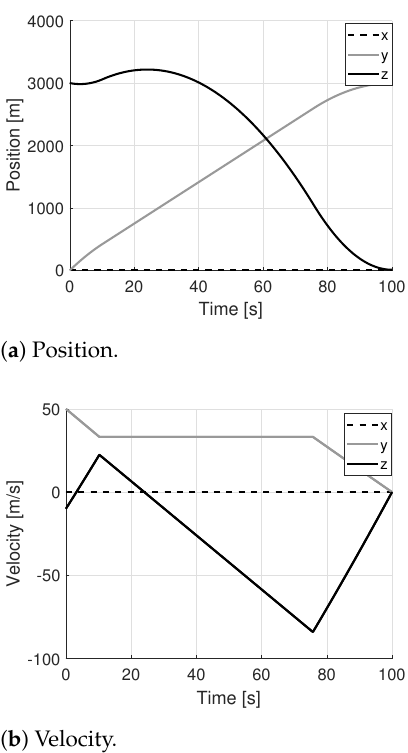
Figure 18. Position and velocity components obtained with